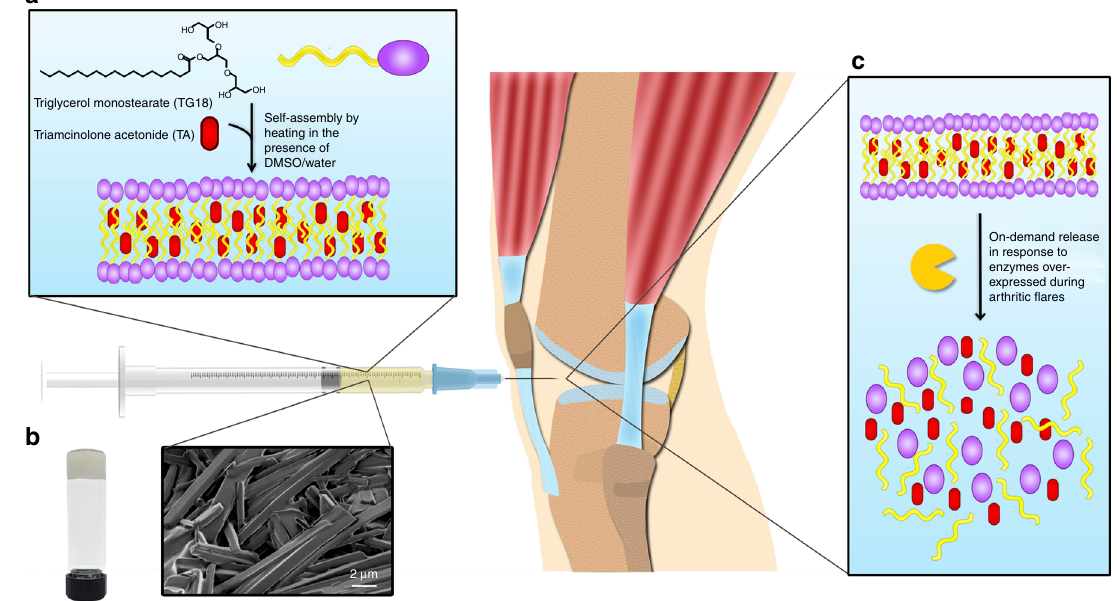
Fig. 1 Triglycerol monostearate (TG-18) self-assembles to form arthritis fl are-responsive hydrogel. a Schematic showing self-assembly of TG-18 to form hydrogel and encapsulation of triamcinolone acetonide (TA). TG-18 dissolves by heating in DMSO/water and self-assembles into lamellar structures upon cooling. Drugs like triamcinolone acetonide (TA) can be encapsulated within the hydrophobic core of the lamellae. b High-resolution scanning electron microscopy (HR-SEM) of TA-loaded TG-18 hydrogels. TG-18 lamellar structures extend to form higher order fi brous assemblies. The entangled fi bers form the bulk injectable hydrogel that can be administered via intra-articular injection. c Disassembly of TG-18 hydrogel in response to fl are-associated enzymes, including MMPs that are present in the in fl amed